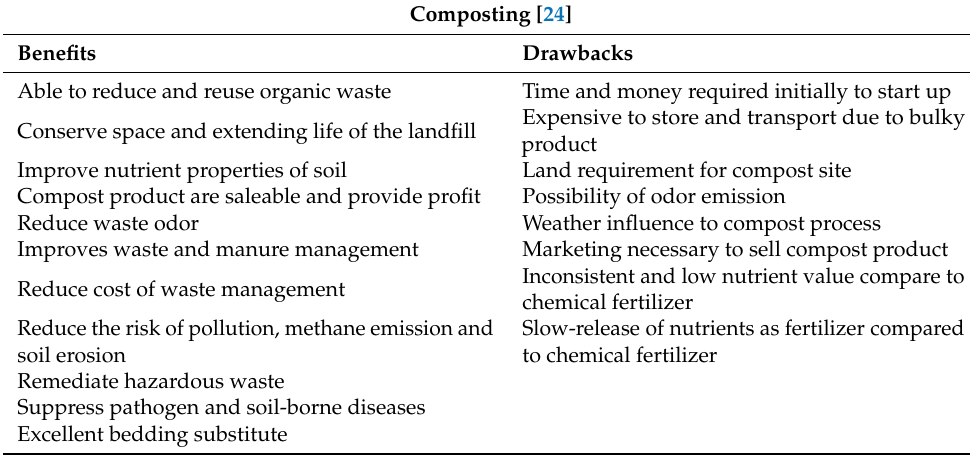
Table 1. Benefits and drawbacks of